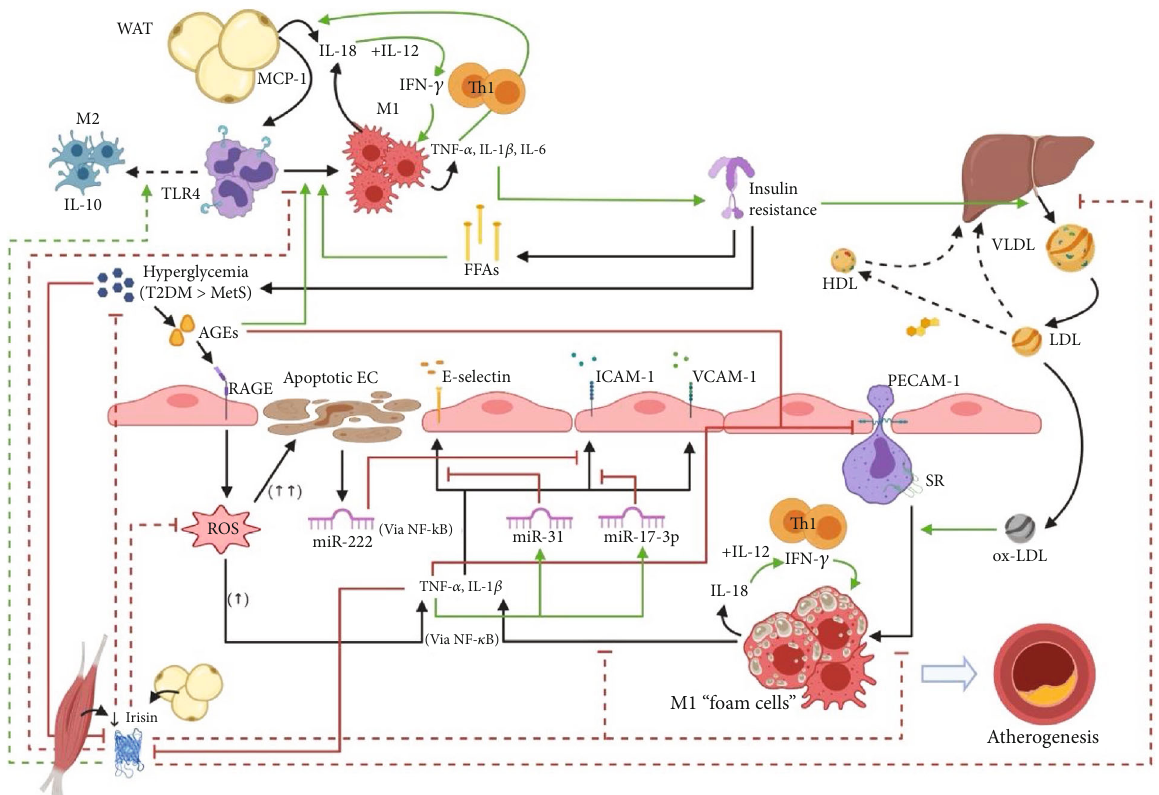
Figure 4: Proposed interplay between low irisin levels, endothelial cell adhesion molecules, and in fl ammatory cytokines in the context of type 2 diabetes mellitus and metabolic syndrome. See text for more detailed information. AGEs: advanced glycation end-products; EC: endothelial cell; FFAs: free fatty acids; HDL: high-density lipoprotein; ICAM-1: intercellular adhesion molecule-1; IFN- γ : interferon gamma; IL-1 β : interleukin-1 beta; IL-6: interleukin-6; IL-10: interleukin-10; IL-12: interleukin-12; LDL: low-density lipoprotein; MCP-1: monocyte chemoattractant protein-1; MetS: metabolic syndrome; miR: microRNA; NF- κ B: nuclear factor-kappa B; ox-LDL: oxidized low-density lipoprotein; PECAM-1: platelet endothelial cell adhesion molecule; RAGE: receptor for advanced glycation end-products; ROS: reactive oxygen species; SR: scavenger receptor; T2DM: type 2 diabetes mellitus; Th1: T-helper 1 cell; TLR4: toll-like receptor 4; TNF- α : tumor necrosis factor-alpha; VCAM-1: vascular cell adhesion protein-1; VLDL: very low-density lipoprotein; WAT: white adipose tissue. This